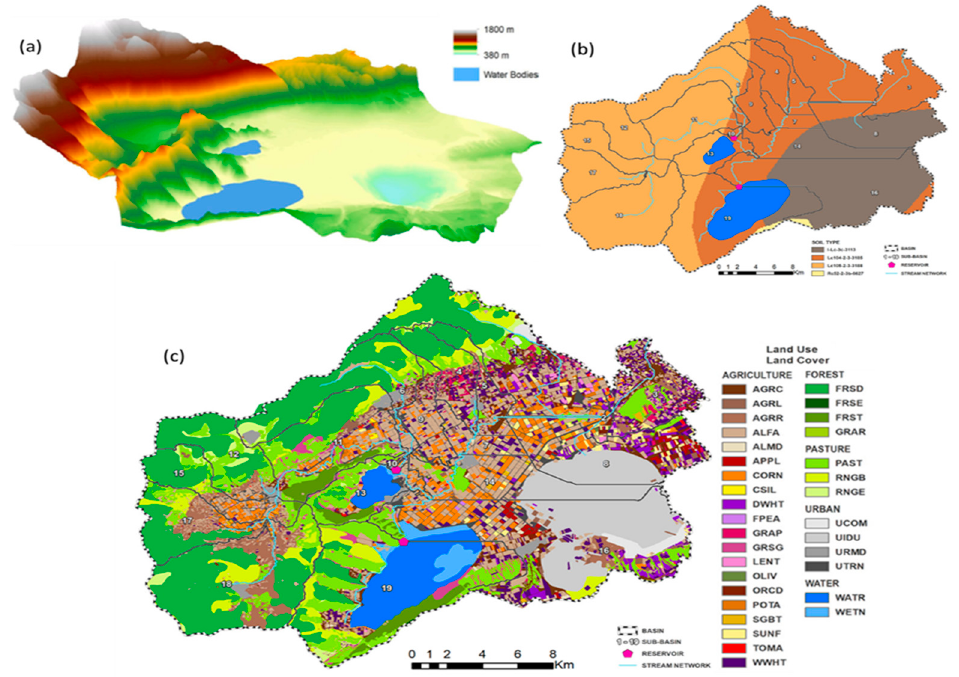
Figure 3. Zazari-Chimaditida river sub-basin area ( a ) digital elevation model (DEM) in 3D mode, ( b ) digital soil map, ( c ) combined reference land use/land cover (LU/LC) map.